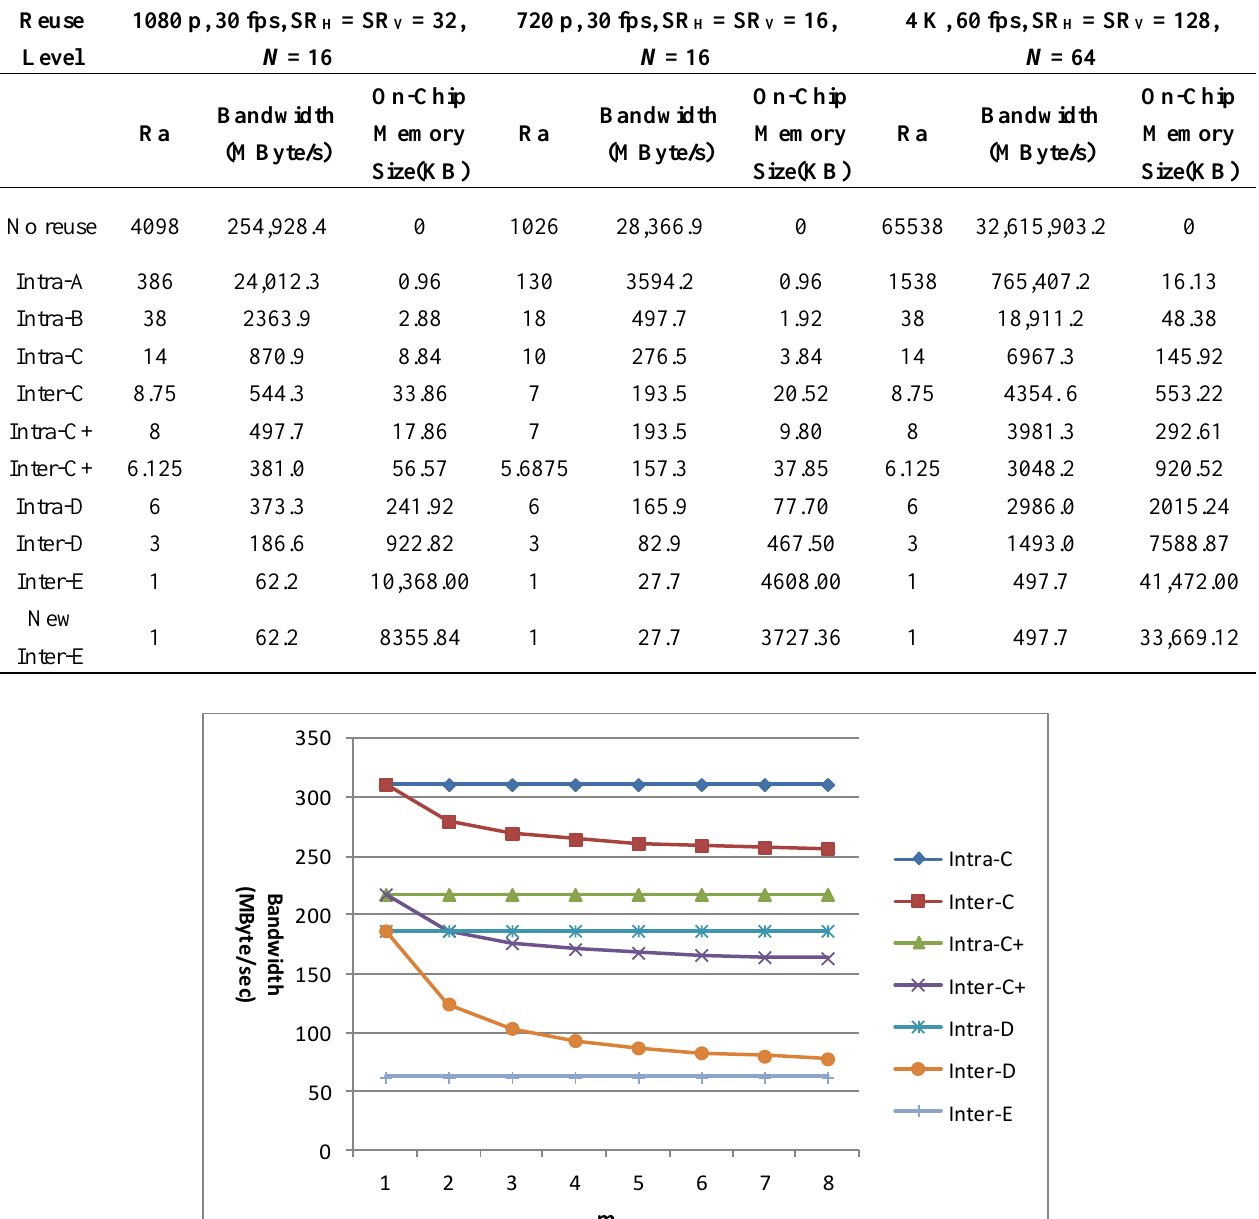
Table 8. Three Case Studies for VC-MRME.